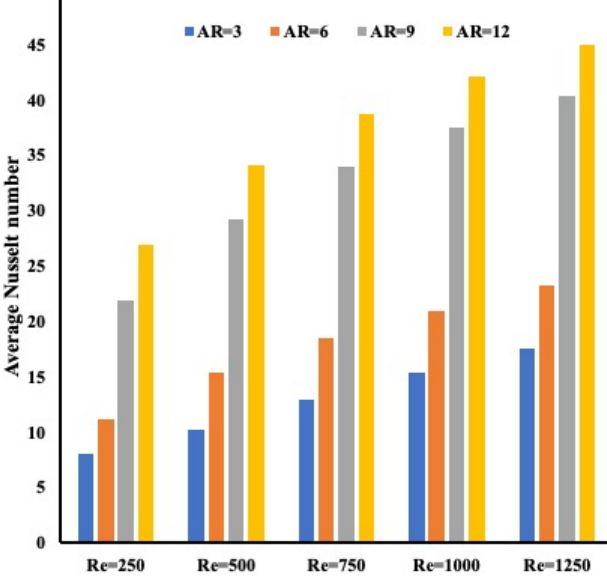
Figure 8. Average Nusselt number for all cases.